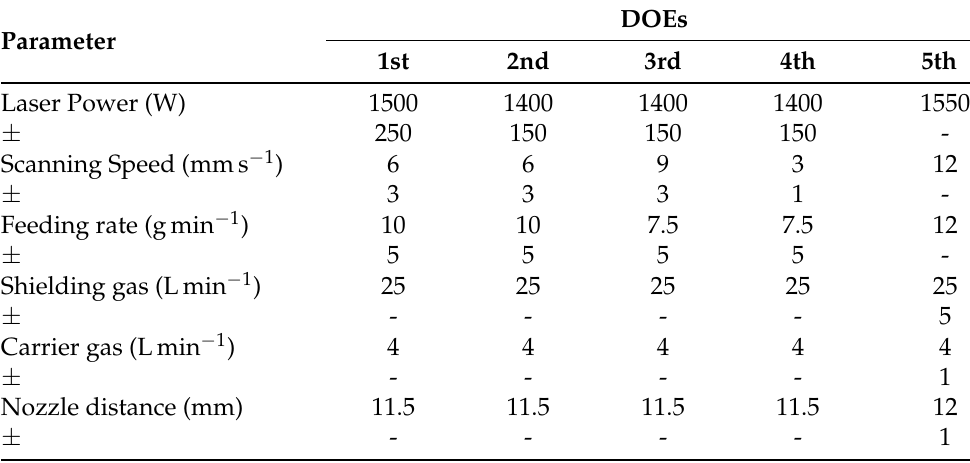
Table 3. Five DOEs conducted during the 18Ni300 process parameter optimisation. The indicates the variation of a parameter in one DOE: for example, the first DOE consisted of line beads with laser powers of 1250, 1500 and 1750W, scanning speeds of 3, 6 and 9mms − 1 and feeding rates of 5, 10 and 15g/